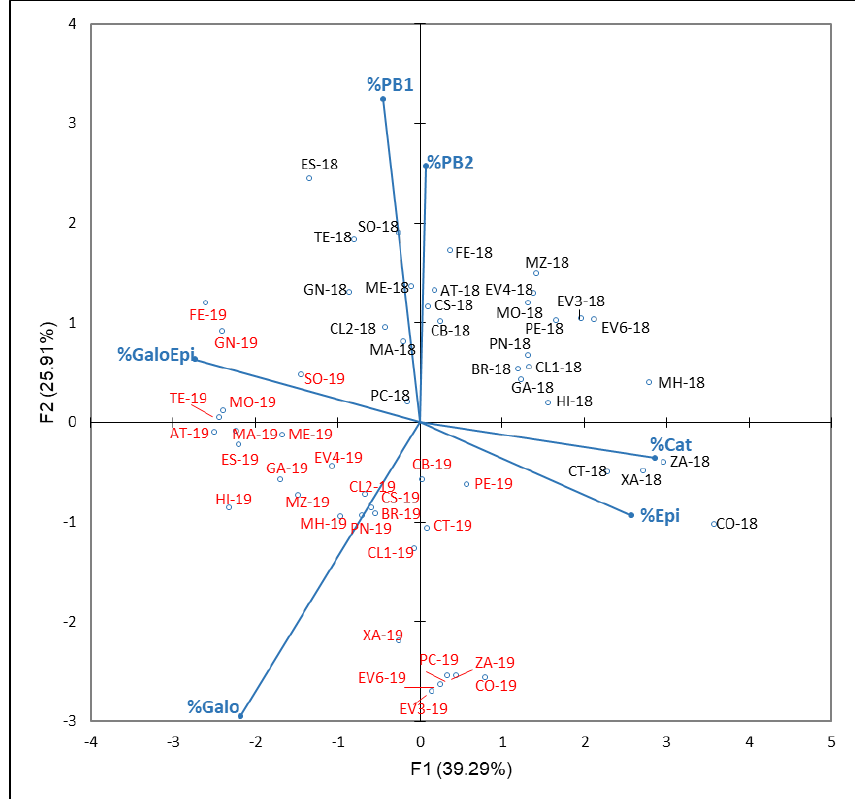
Figure 7. Principal component analysis on flavanol family compounds profile (percentage) of grapes from the EVEGA germplasm bank in 2018 and 2019 vintages. % Cat, % Galo, % Epi, % GaloEpi, % PB1 and % PB2 are percentages of catechin, gallocatechin, epicatechin, epicatechin gallate, procyanidin B1 and procyanidin B2, respectively, with respect to TPC values. Data for the black and red varieties reflect the data for 2018 and 2019 harvests respectively. See Table 1 for varieties abbrevia- tions.